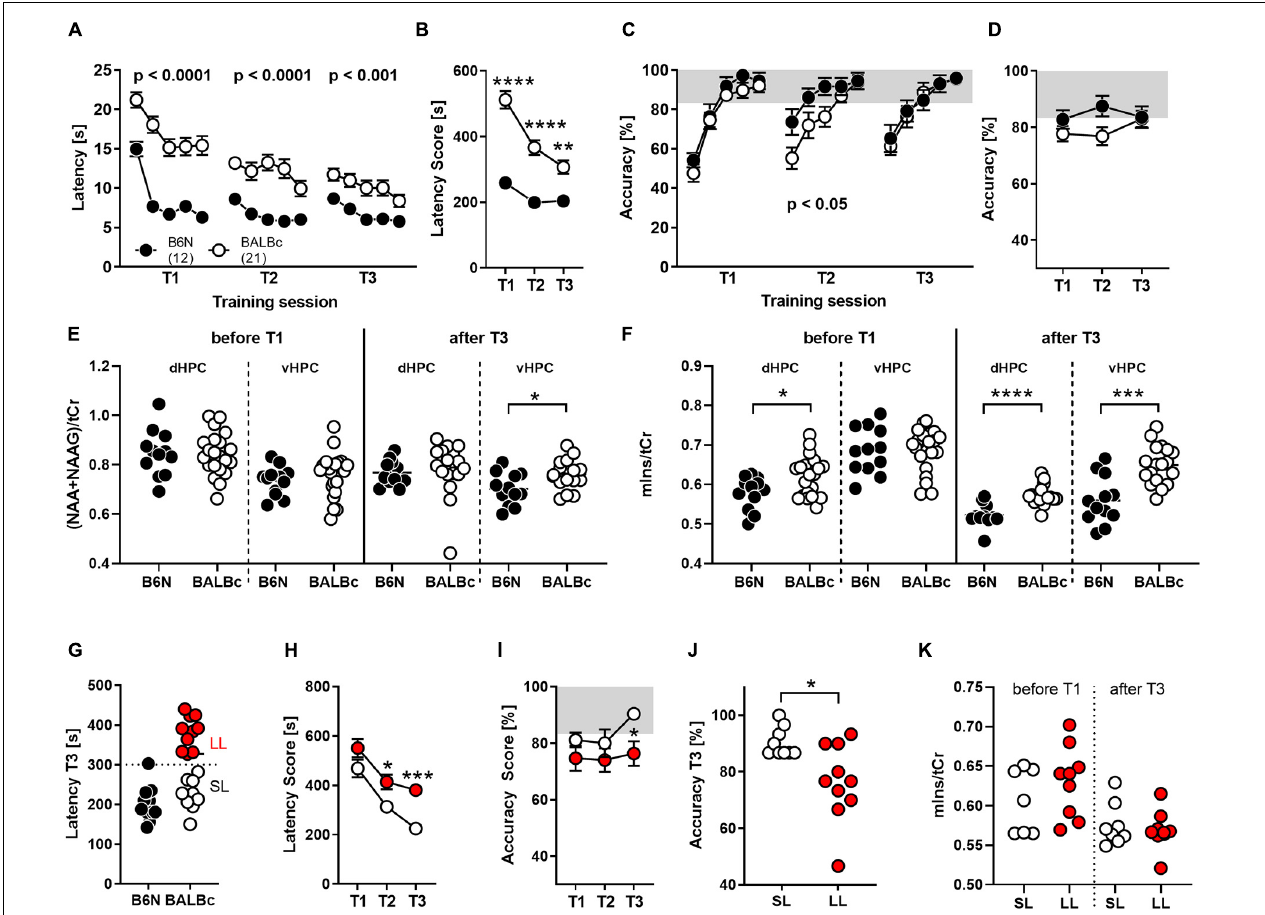
FIGURE 2 | BALBc mice showed persistent deficits in WCM learning, but not memory, over time coinciding with increased mIns levels both in the beginning and the end of the experiment. To investigate the performance of both strains with increasing age, B6N ( n = 12) and BALBc ( n = 19) mice were repeatedly trained in the WCM to find a hidden platform in a fixed position at an age of 3 months (T1), 7 months (T2), and 12 months (T3). Before T1 and after T3, 1 H-MRS measurements have been performed in both mice strains. (A) BALBc mice showed increased escape latencies throughout training, whereby (B) the performance of the two strains started to converge toward the end of training. (C,D) BALBc mice also showed a deficit in accuracy compared to B6N (T2). This strain difference, however, was transient. (E) As assessed by repeated 1 H-MRS (before the start and after completion of the whole experiment), there were no strain differences in NAA + NAAG at the level of the dorsal and ventral hippocampus except for the late time point. (F) In contrast, mIns levels differed before and after repeated training in the dorsal hippocampus (dHPC) or after training in the ventral hippocampus (vHPC). (G) We assigned the BALBc mice to two groups, based on their escape latency shown during T3, using an arbitrary threshold of 300 s to distinguish between long-latency (LL) and short-latency (SL) mice. (H) LL and SL mice differed in escape latencies already during T2 and (I,J) in accuracy during T3. (K) These effects, however, were not mirrored by differences in mIns levels [tCr = total creatine (creatine + phosphocreatine)]. * p < 0.05, ** p < 0.01, *** p < 0.001, **** p < 0.0001 (2-way ANOVA followed by Tukey’s post hoc test or t -test).